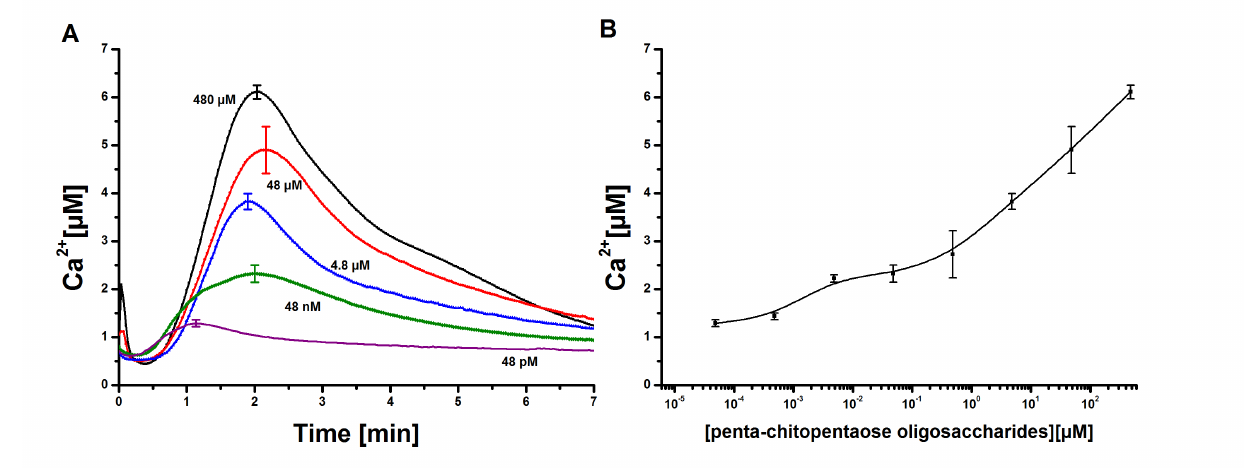
Figure 2. Measurement and quantification of cytosolic Ca 2+ concentrations in tobacco cell cultures upon elicitation with N -acetylchitopentaose oligosaccharides. ( A ) Dose-dependent Ca 2+ kinetics for the acetylchitopentaose oligosaccharides (Ch5) elicitor measured in tobacco plant cell cultures. The elicitor concentration was chosen in the range of 48 pM to 480 µM. Each cytosolic Ca 2+ curve has a delay time of 50 s and a faster increase than decrease. Three replicates of every single concentration were taken. The cytosolic Ca 2+ curves shown constitute the calculated mean of the three replicates. Error bars indicate standard deviation. ( B ) Dose-response diagram of the measured Ch5-induced Ca 2+ transients. The maxima of cytosolic Ca 2+ responses are recorded for each concentration. The resulting curve shows a clear rise; higher elicitor concentrations lead to stronger Ca 2+ responses. Error bars indicate standard